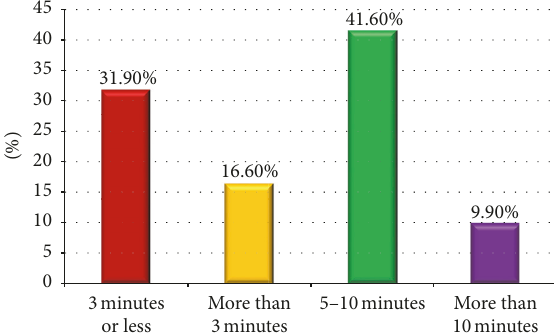
Figure 4: Duration of brushing among study subjects.